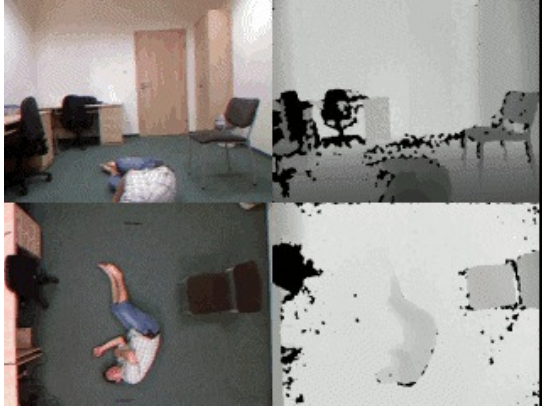
Figure 24. Sample Images from the URfall dataset. The figure was captured from the demo video on the UR Fall Dataset website